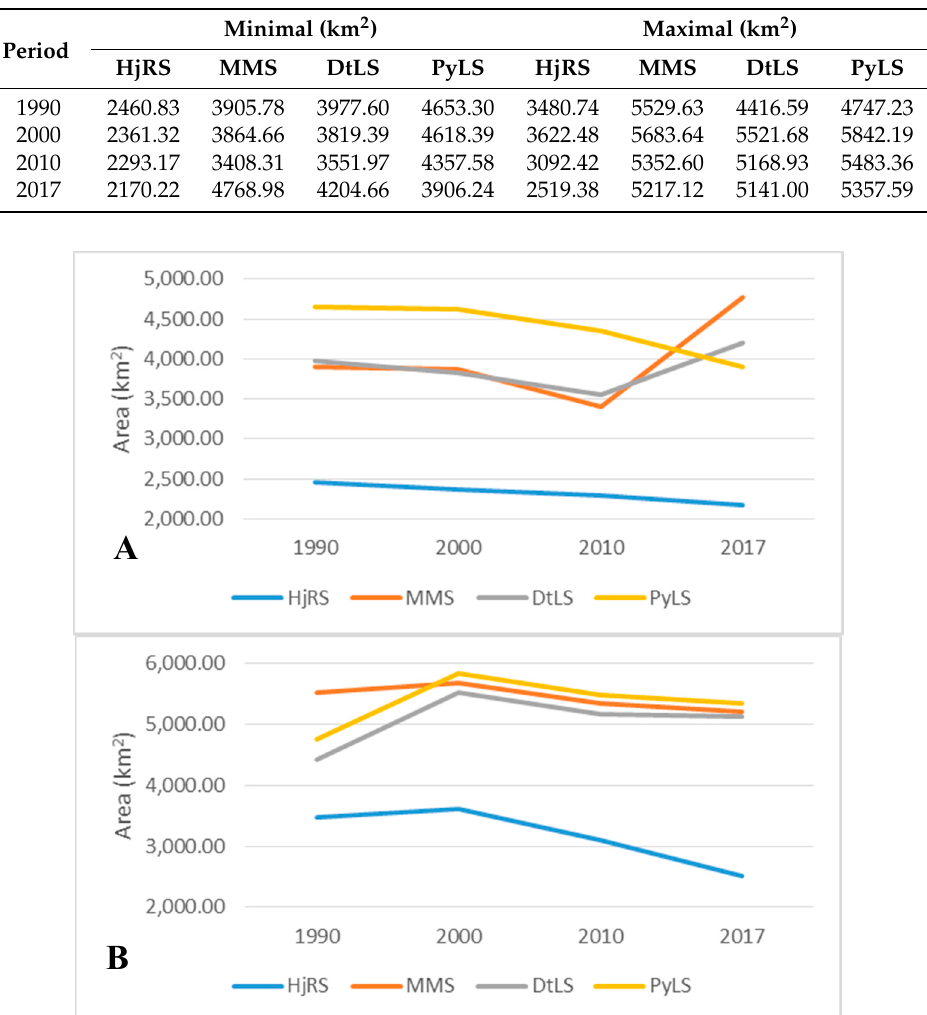
Figure 9. Dynamics of surface water extents in four sub-basins based on minimal and maximal extent. ( A ) Areal changes in minimal surface water extent in all four sub-basins. ( B ) Area changes in maximal surface water extent in all four sub-basins.